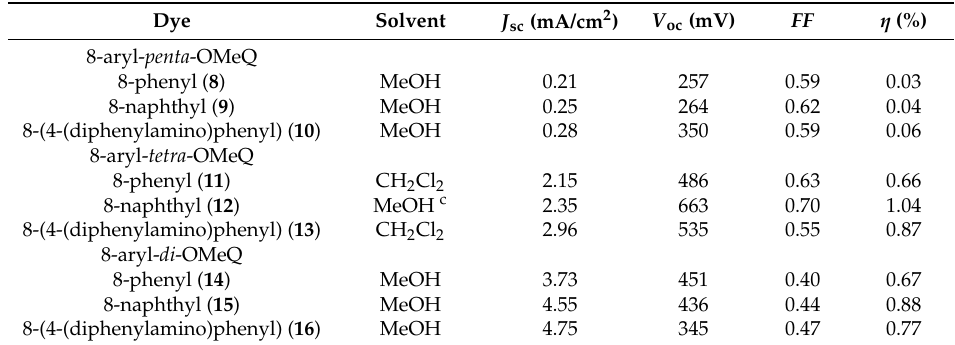
Table 5. Photovoltaic properties of the DSSCs sensitized with 8-aryl- O -methylquercetins ( 8 – 16 ) a,b . Dye